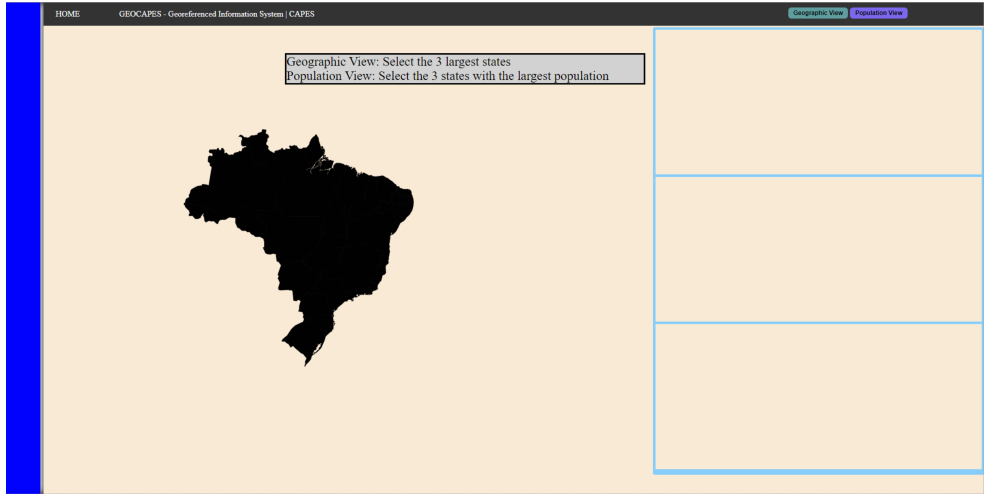
Figure 6. Simulated scenario 1 based on a generic dashboard in a web service with